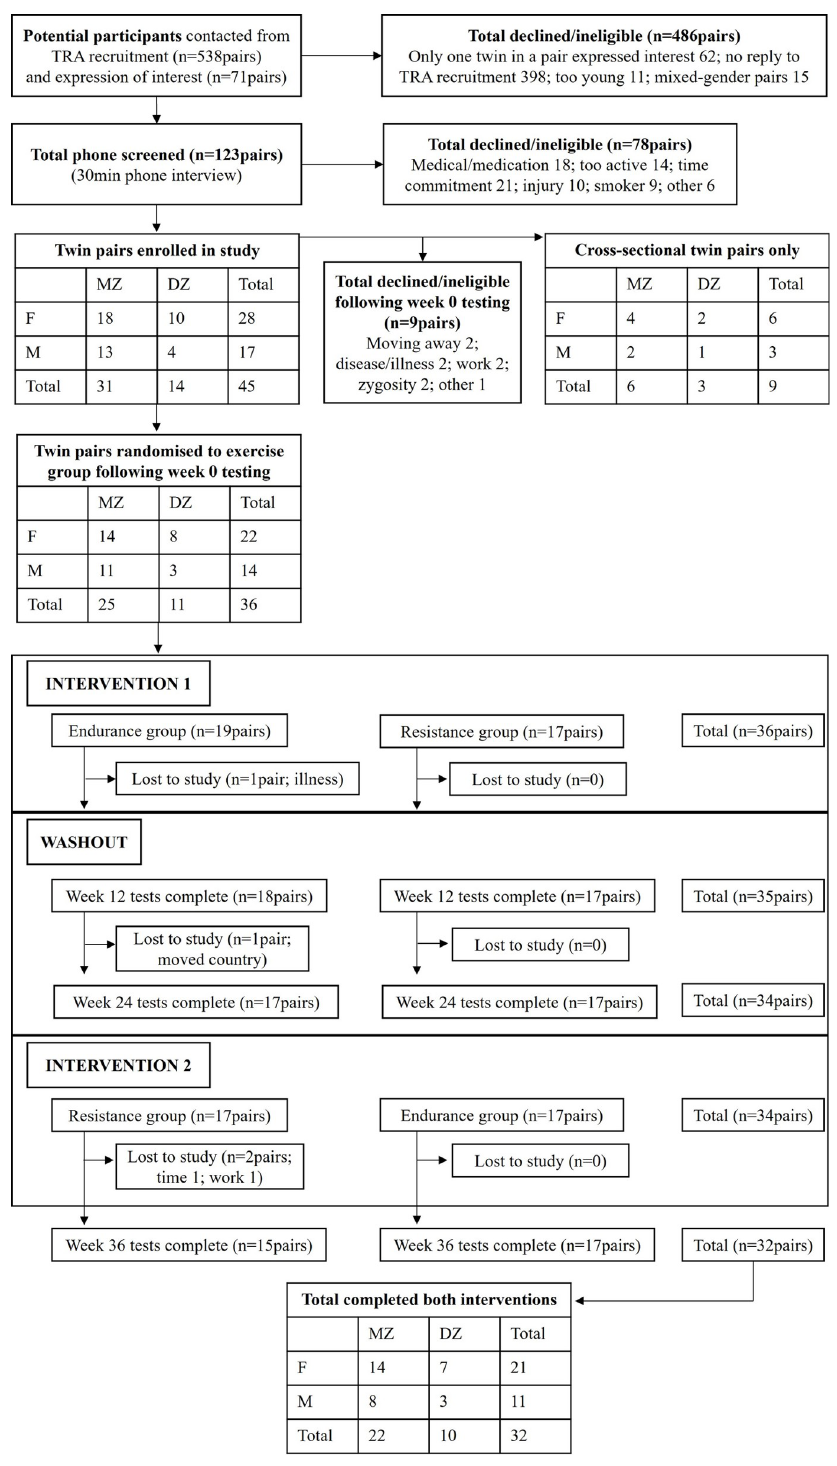
Fig 1. Consort flow